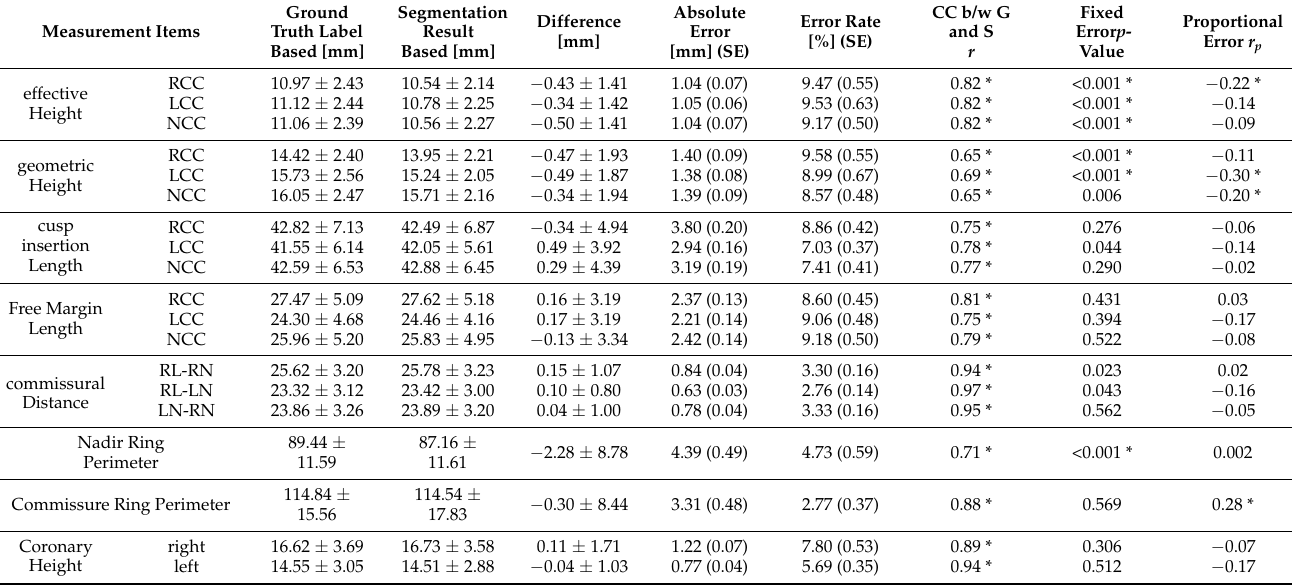
Table 3. Segmentation Results by difference of